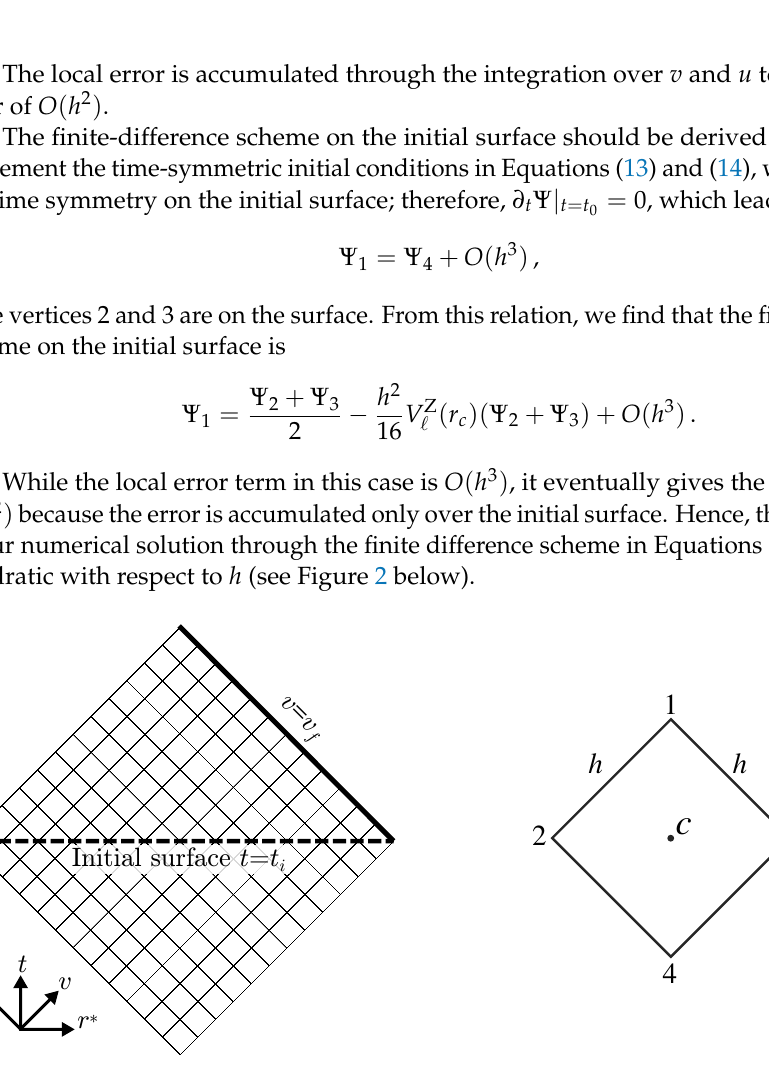
Figure 1. ( Left ) Schematic picture of the numerical domain in the double null coordinates, ( u = t − r ∗ , v = t + r ∗ ) . We impose the close-limit, PN initial condition in Equations (13) and (14) on the surface with t = t i (the bold dashed line) and extract the waveform on the surface with v = v f (the bold solid line). ( Right ) A cell in the numerical domain with the size of h × h , where h is the resolution, and C denotes the center of the